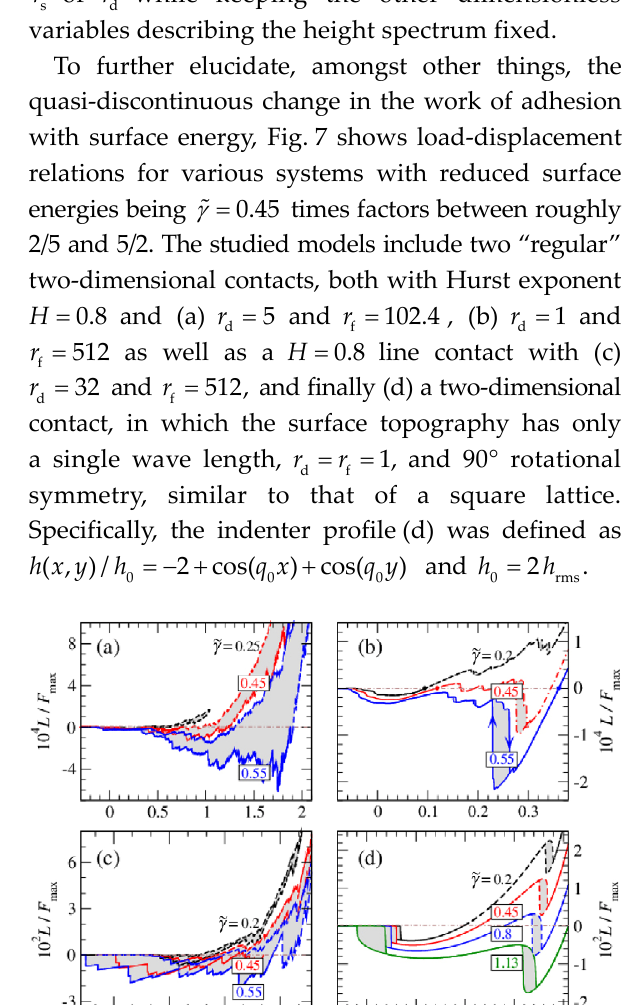
/ L F , as a function max / d h in approach and rms